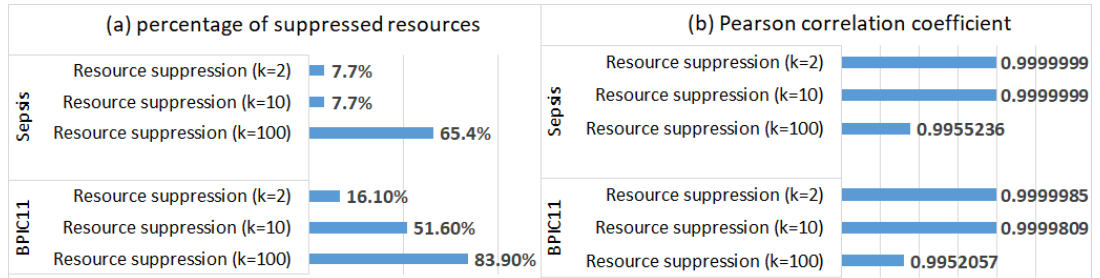
Figure 8. The impact of resource suppression on the results of social network discovery: ( a ) the percentage of suppressed resources, and ( b ) similarity between the arc weights in the social networks discovered from the logs with suppressed events and the corresponding arc weights in the social networks discovered from the original logs (Pearson correlation